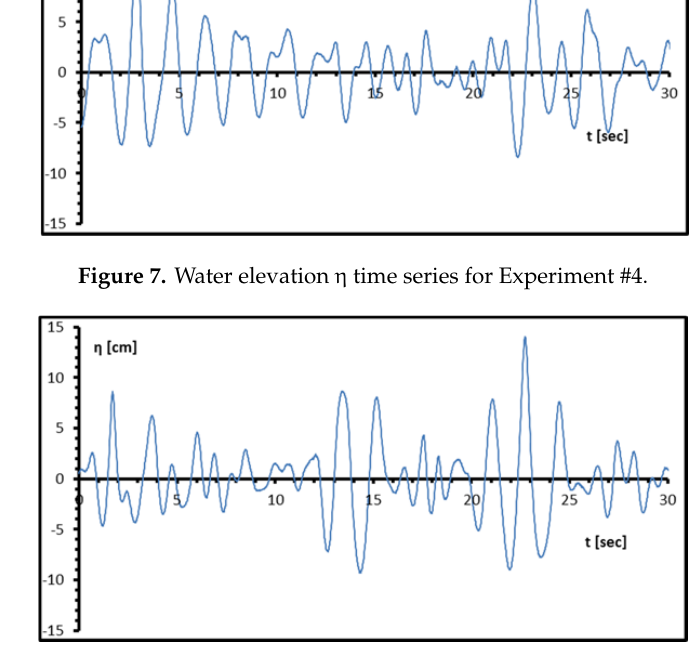
Figure 8. Water elevation η time series for Experiment #5.